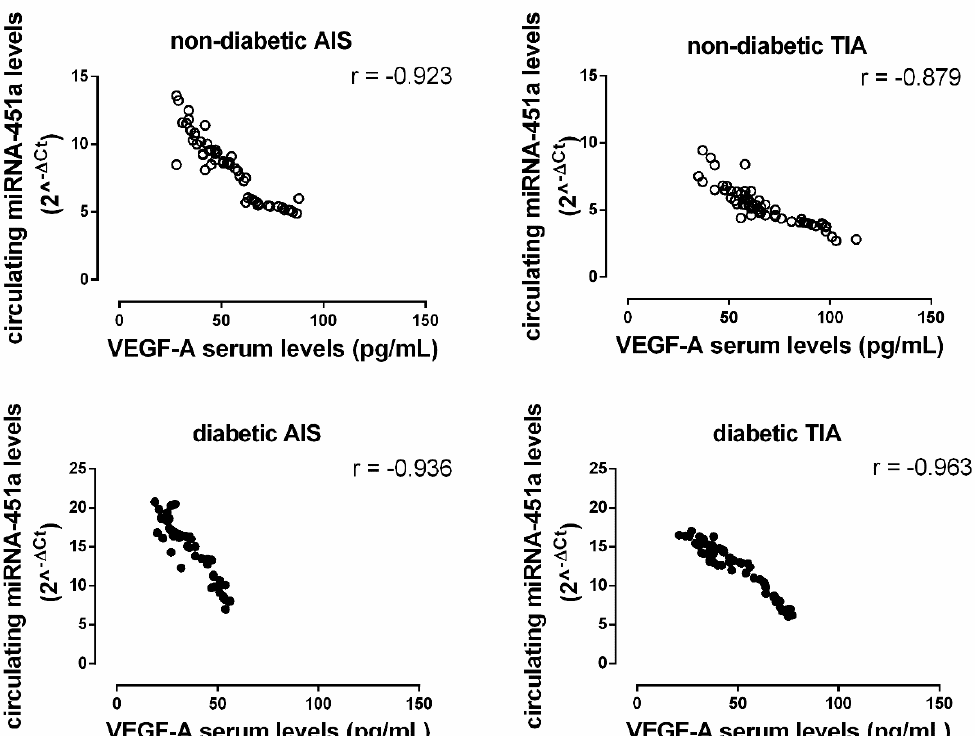
Figure 4. The correlation between miRNA-451a levels (2 ^- Δ Ct ; y -axis) with the serum levels of vascular endothelial growth factor-alpha (VEGF-A; pg / mL; x -axis) in both non-diabetic (ND; empty circle) and diabetic (D; solid black circle) AIS and TIA groups. All correlations are significant at p < 0.05.